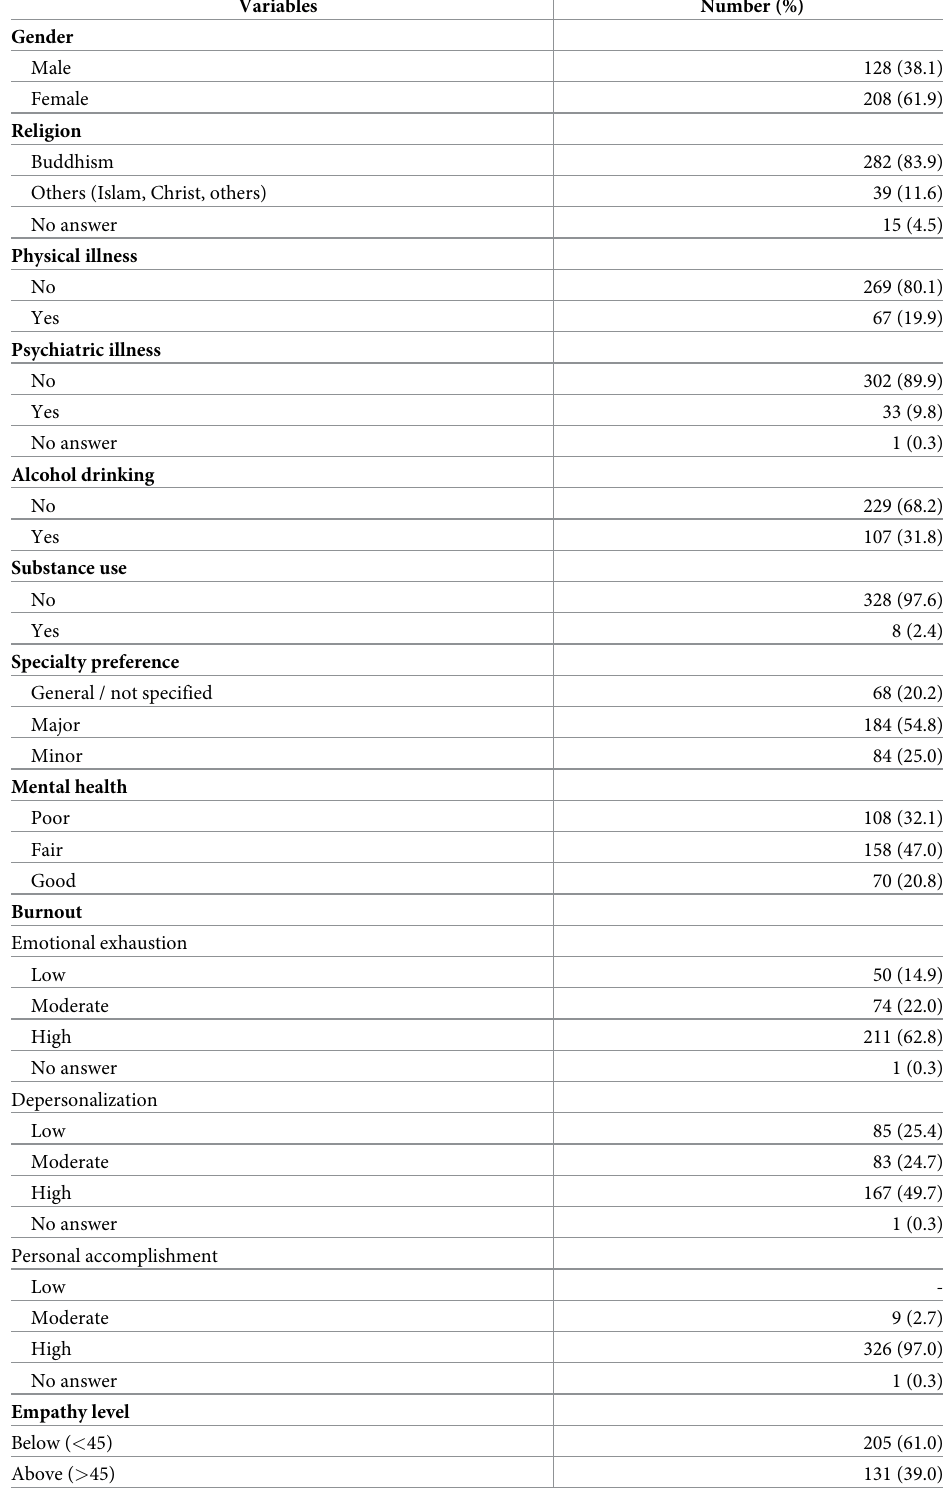
Table 1. Demographic characteristics, mental health, burnout, and empathy level (N =